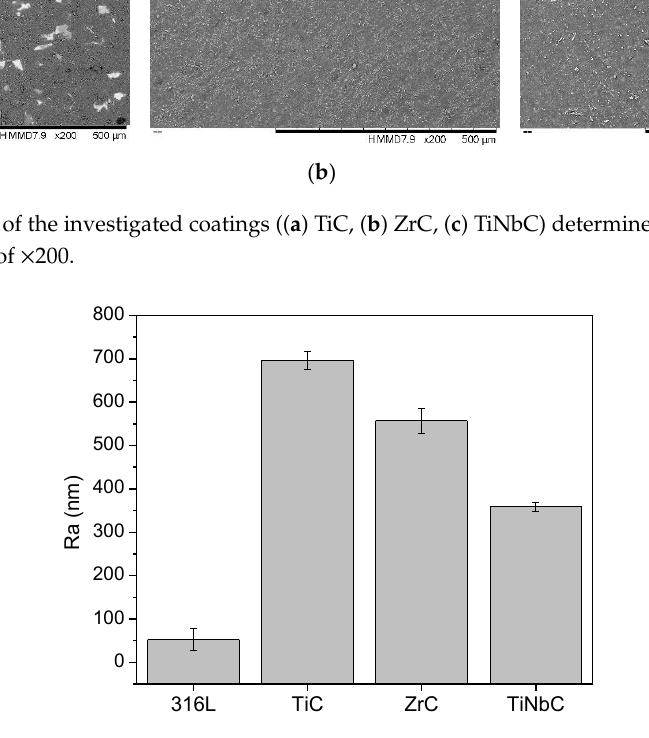
Figure 3. The arithmetic average deviation from the mean line of the roughness profile ( R a ) of substrate and coatings measured on a distance of 4 mm using surface profilometry.